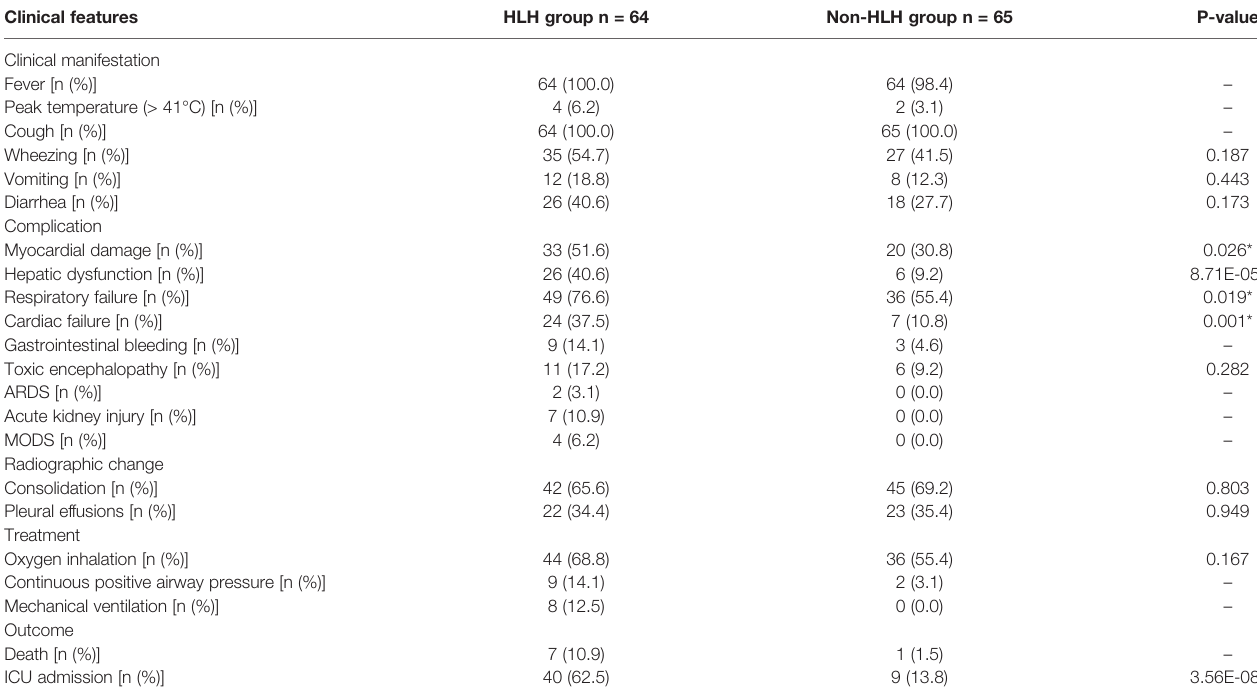
TABLE 1 | Clinical features of HLH and non-HLH patient